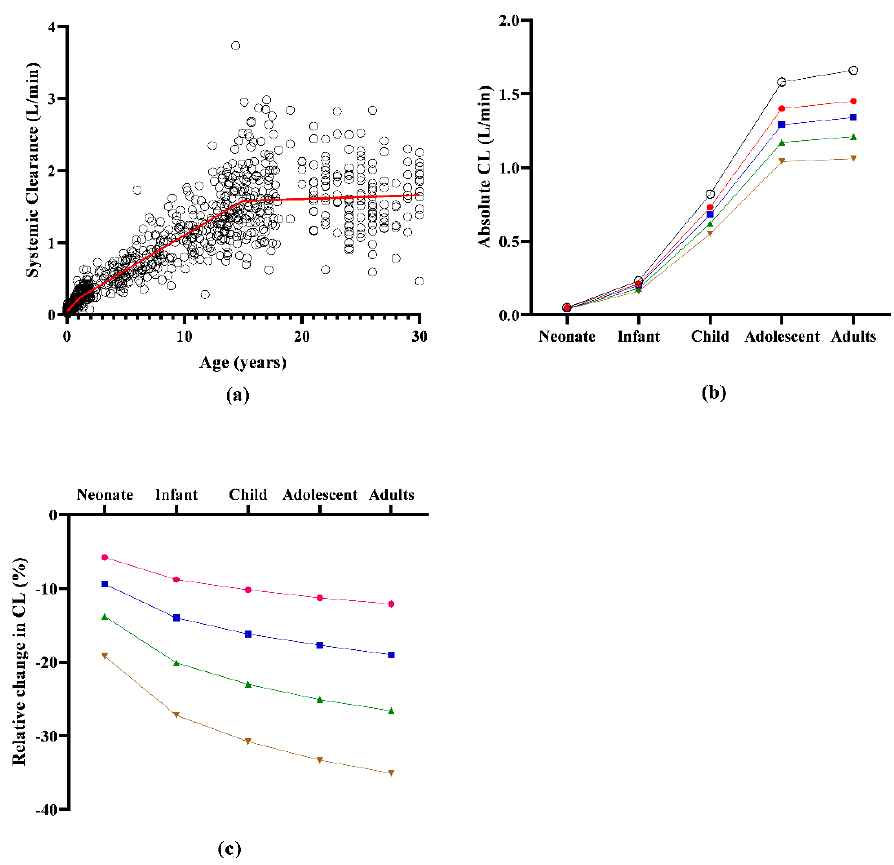
Figure 2. Predicted changes in systemic clearance of propofol under normal or reduced CO conditions. ( a ) Predicted changes in absolute clearance with age. ( b ) Predicted changes in absolute clearance with age under reduced CO conditions. ( c ) Relative percentage changes in systemic clearance under reduced CO conditions with age. Open circles represent individual clearance in virtual subjects. ( b ) Absolute clearance and ( c ) relative change in clearance of propofol under reduced cardiac output conditions across age groups. For all Figure 2a–c, black open circle and line, red circles and line, blue squares and line, green triangle and line and brown inverted triangles and line represent clearance under normal, 20%, 30%, 40% and 50%-reduced cardiac reduction, respectively. Table 1. Predicted clearance of propofol across age groups.